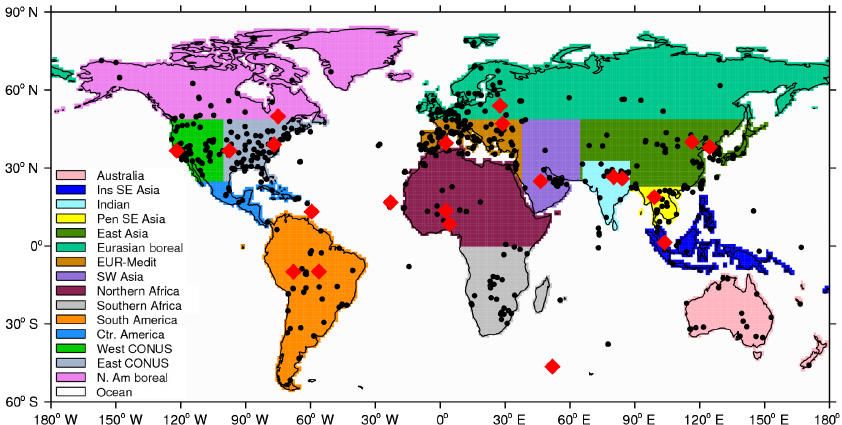
Figure 4. Selection of regions for this study. Antarctica is excluded. All AERONET sites that have valid L2 data for the study period (2003–2013) are in black dots. The selected sites for detailed validation (Sect. 3.2.3) are highlighted with red